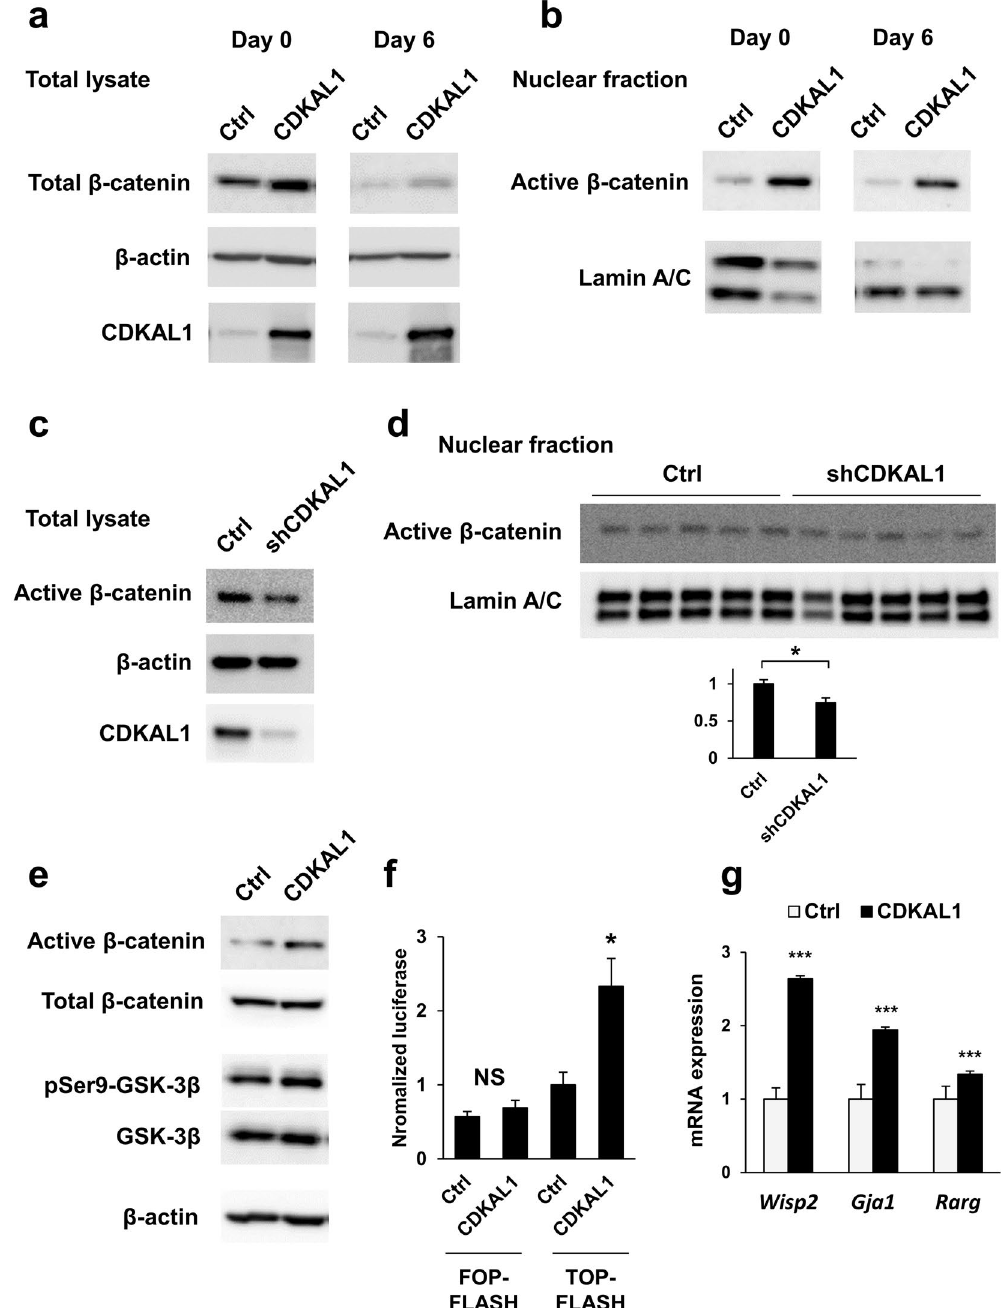
Figure 4. Activation of Wnt/ β -catenin signaling pathway by CDKAL1. ( a ) Western blotting of β -catenin in 3T3-L1 expressing CDKAL1 on day 0 and day 6 of differentiation. β -actin was used as an internal control for protein loading. The experiments were repeated multiple times and representative blot was shown. ( b ) Western blotting of active (unphosphorylated) β -catenin in the nuclear fraction in 3T3-L1 expressing CDKAL1. ( c , d ) The effect of stable knockdown of CDKAL1 by shRNA in 3T3-L1 cells on protein levels of active β -catenin in total lysate ( c ) and in the nuclear fraction ( d ). The inset graph in ( d ) shows quantification of the active β -catenin ( * p < 0.05 vs control group by Student’s t-test). ( e ) Western blotting of β -catenin and inactive form of GSK-3 β (phosphorylated at Ser 9) in 3T3-L1 expressing CDKAL1. ( f ) Measurement of Wnt signaling activities by TOPFLASH reporter assay in 3T3-L1 cells. FOPFLASH reporter was used as the negative control (n = 6, * p < 0.05 vs control group by Student’s t-test). ( g ) Gene expression changes of Wnt target genes in 3T3-L1 cells expressing CDKAL1 (12 hours after the initiation of differentiation, n = 3, *** p < 0.001 vs control group by Student’s